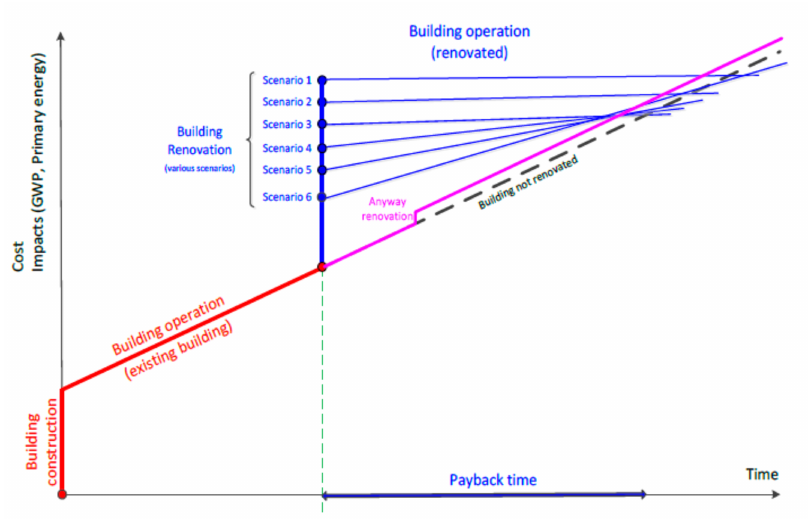
Figure 1. Representation of the effect of energy related renovation measures compared to the existing situation. Source: [26]. GWP: Global warming